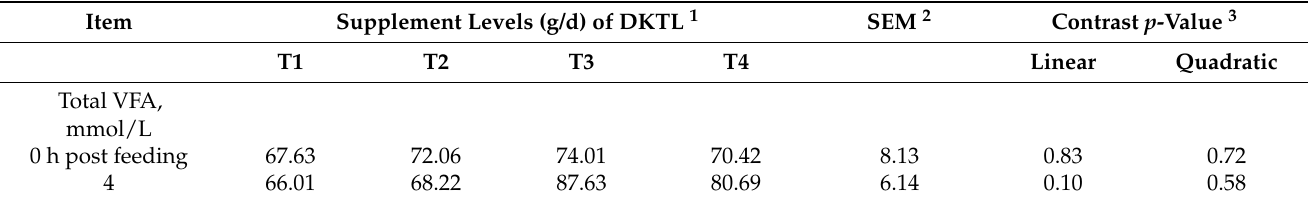
Table 11. Effects of supplement levels (g/d) of dried kratom leaves on volatile fatty acid profiles of